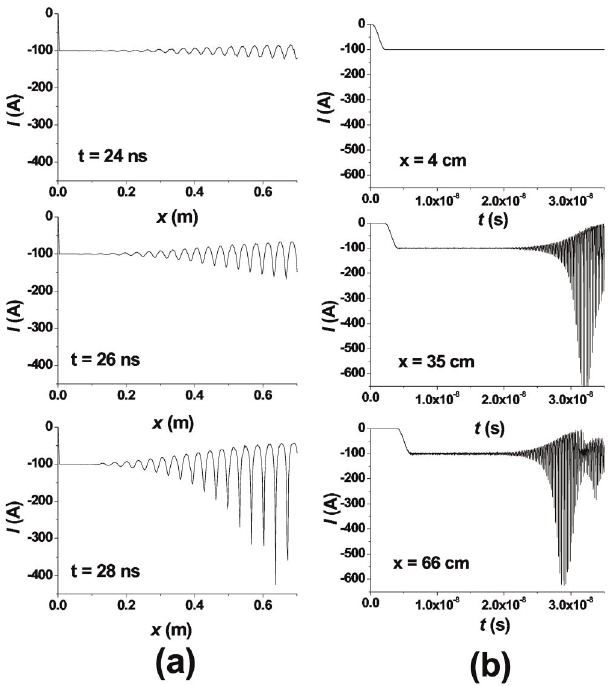
FIG. 7. Projected phase-space distributions: (a) density of electrons in the x - y plane at 32 ns. Bunching is evident. (b) kinetic energy- x density at same